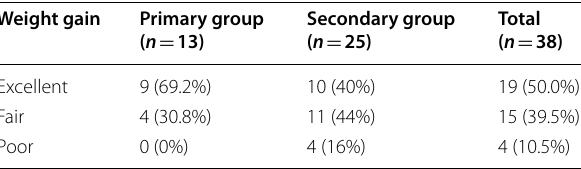
Table 9 Post-operative weight gain among survivors ( n